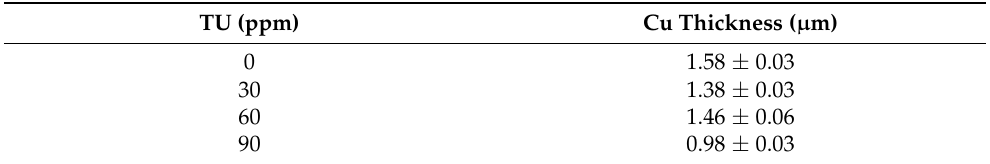
Table 2. XRF analysis of the copper films’ thickness obtained from the solutions with 0, 30, 60 and 90 ppm TU by potentiostatic deposition.